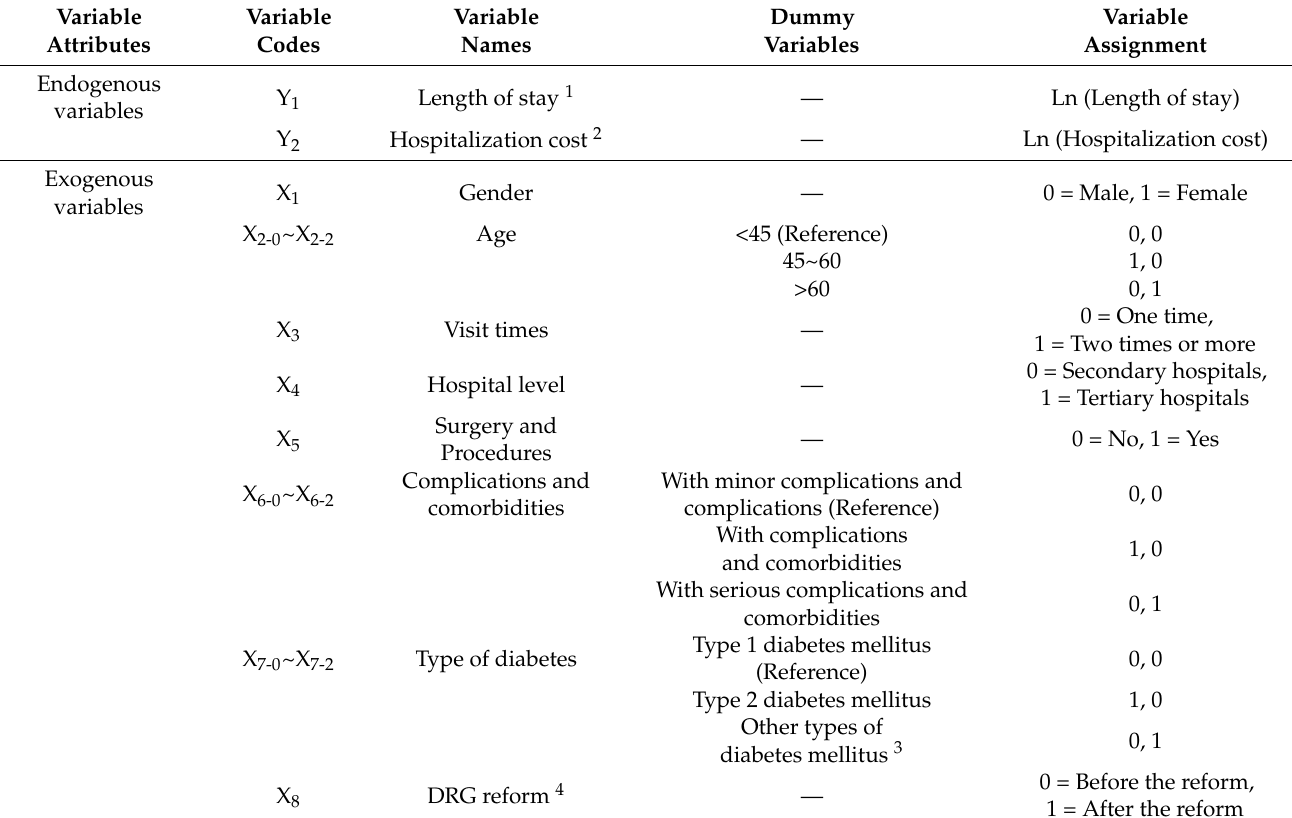
Table 1. Variable assignment processing